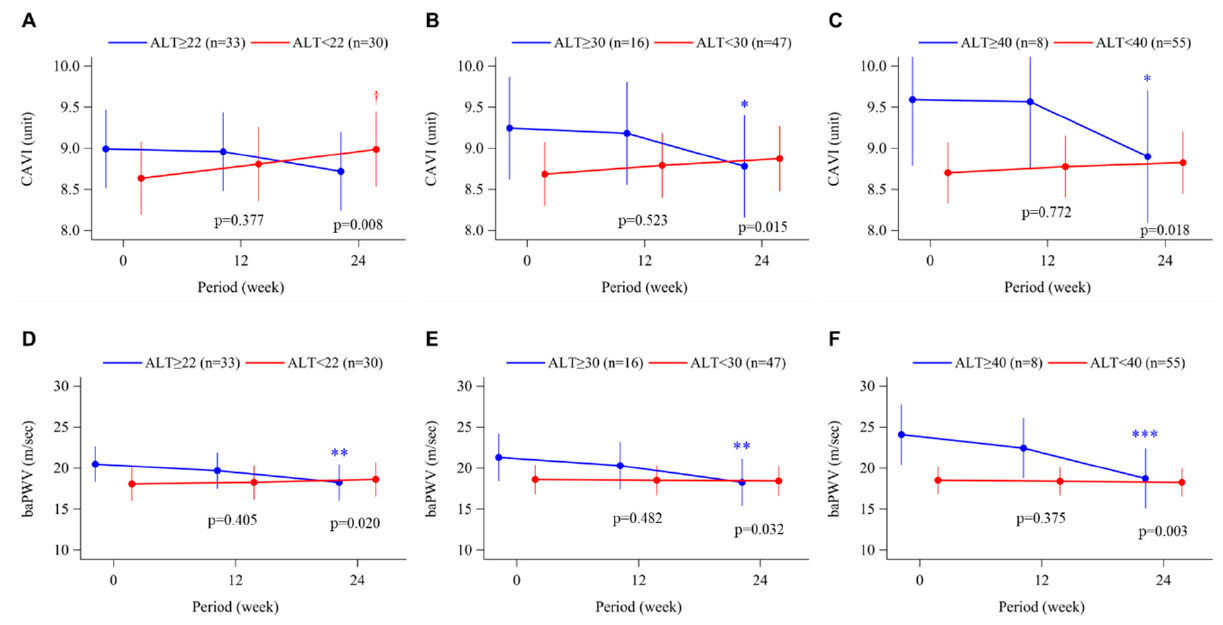
Figure 1. Time course of changes in the cardio-ankle vascular index (CAVI; A – C ) and brachial-ankle pulse wave velocity (baPWV; D – F ) from baseline to week 24 in the topiroxostat-treated group. Patients were divided into groups according to baseline alanine aminotransferase (ALT) level, above or below 22 U/L (median value; A , D ), 30 U/L ( B , E ), and 40 U/L (upper limit of normal; C , F ). Points and bars represent the least-squares mean and 95% confidence interval values using a mixed-effects model with repeated measures adjusted for sex and age. p -values within each graph are for the between-group difference in change from baseline. * p < 0.05, ** p < 0.01 and *** p < 0.001 for change from baseline in the ALT-high group. † p < 0.05 for change from baseline in the ALT-low group.